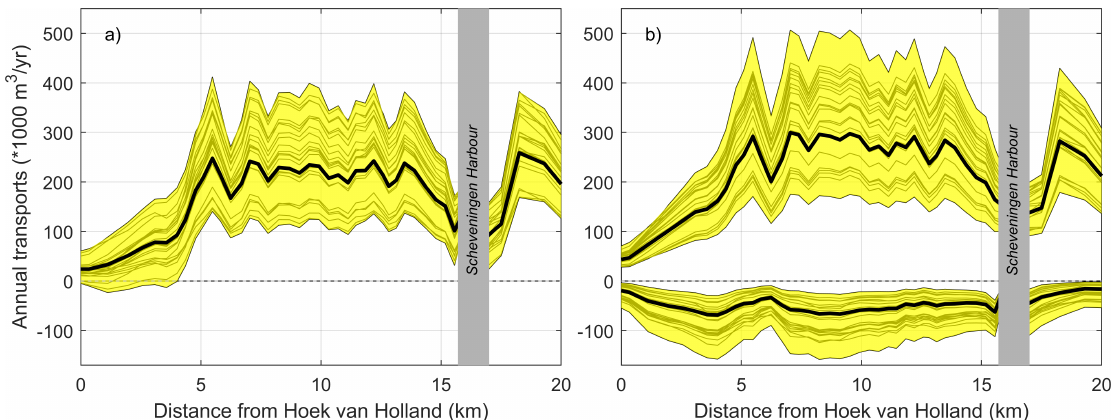
Figure 8. Envelope of the alongshore distribution of the annual ( a ) net and ( b ) gross longshore transports for the years 1985–2015. The grey lines are the annual longshore transport rates calculated using the 214 wave conditions and the measured probability of occurrence of the waves for each year. The black curves indicate the ( a ) net and ( b ) northerly and southerly longshore transports based on 10 wave conditions derived with OPTI to be used in the NLST and GLST